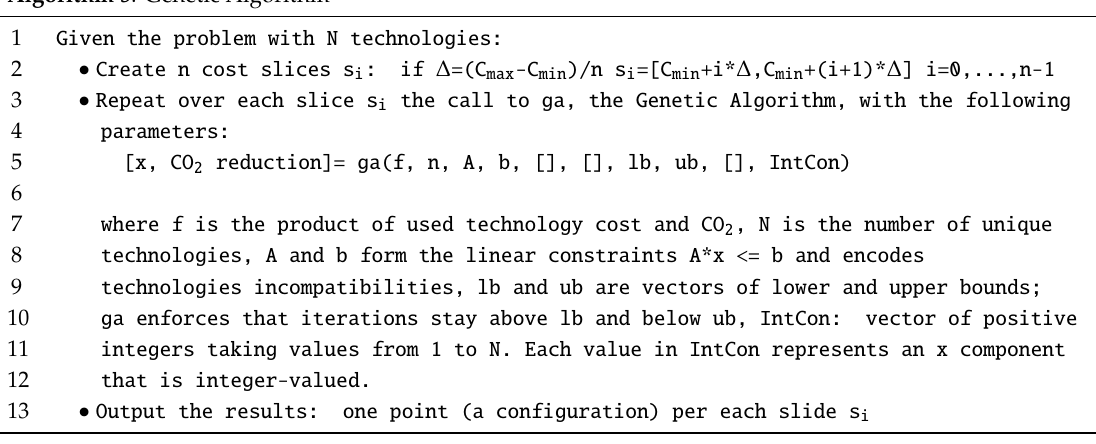
Algorithm 5 . Genetic Algorithm